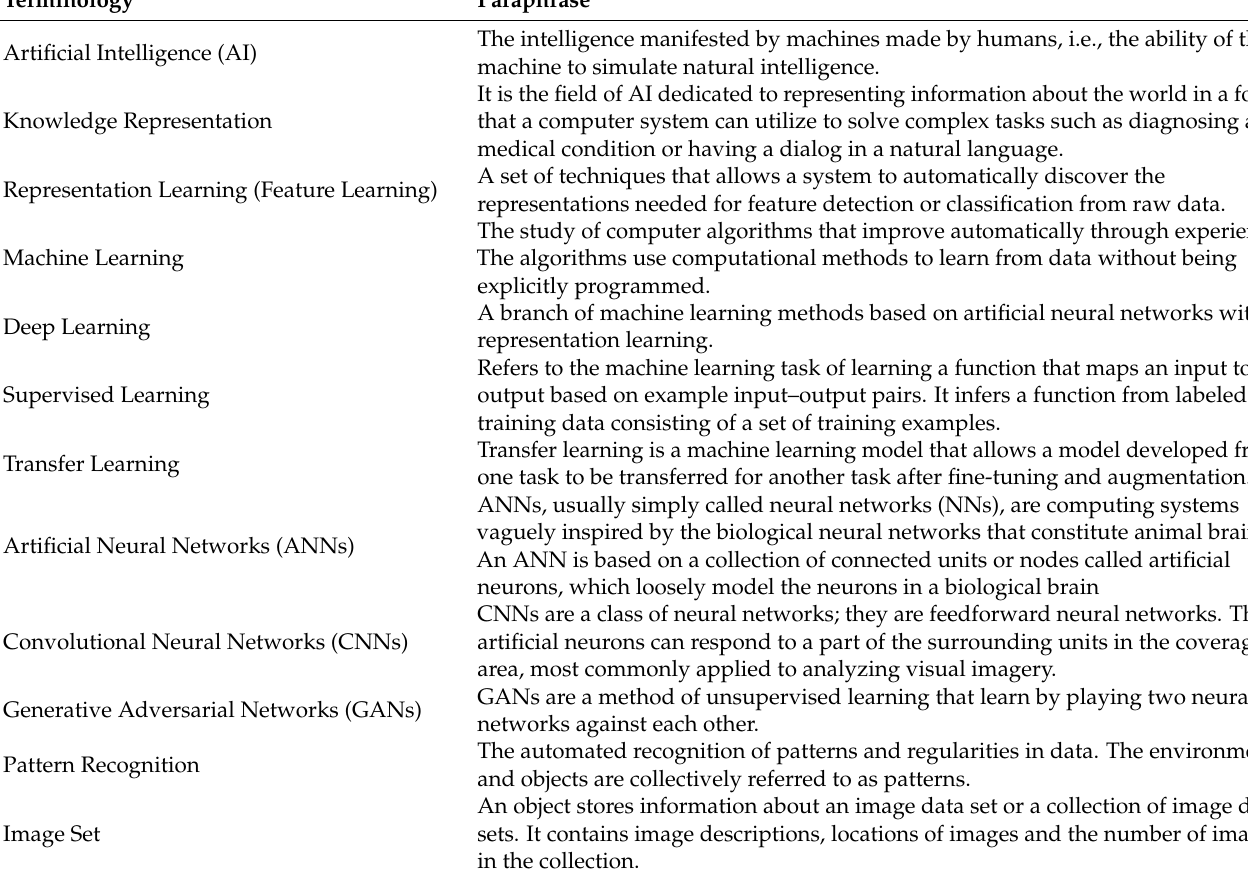
Table 1. Essential terminologies involved in AI in